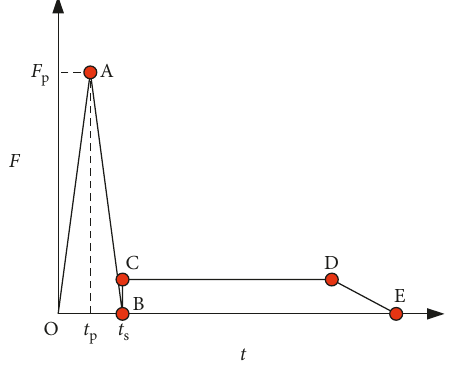
Figure 1: Idealized time history of the impact